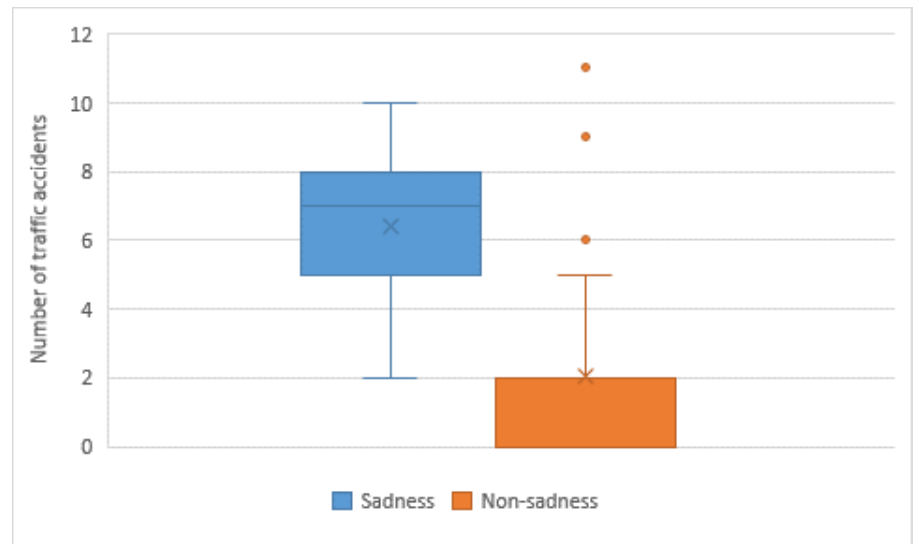
Figure 4. Number of traffic accidents grouped by sadness level.